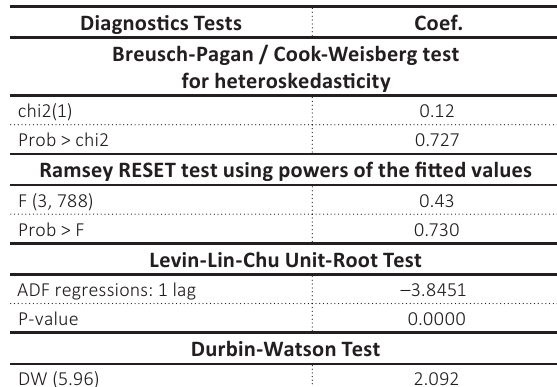
Table 5. Diagnostics tests